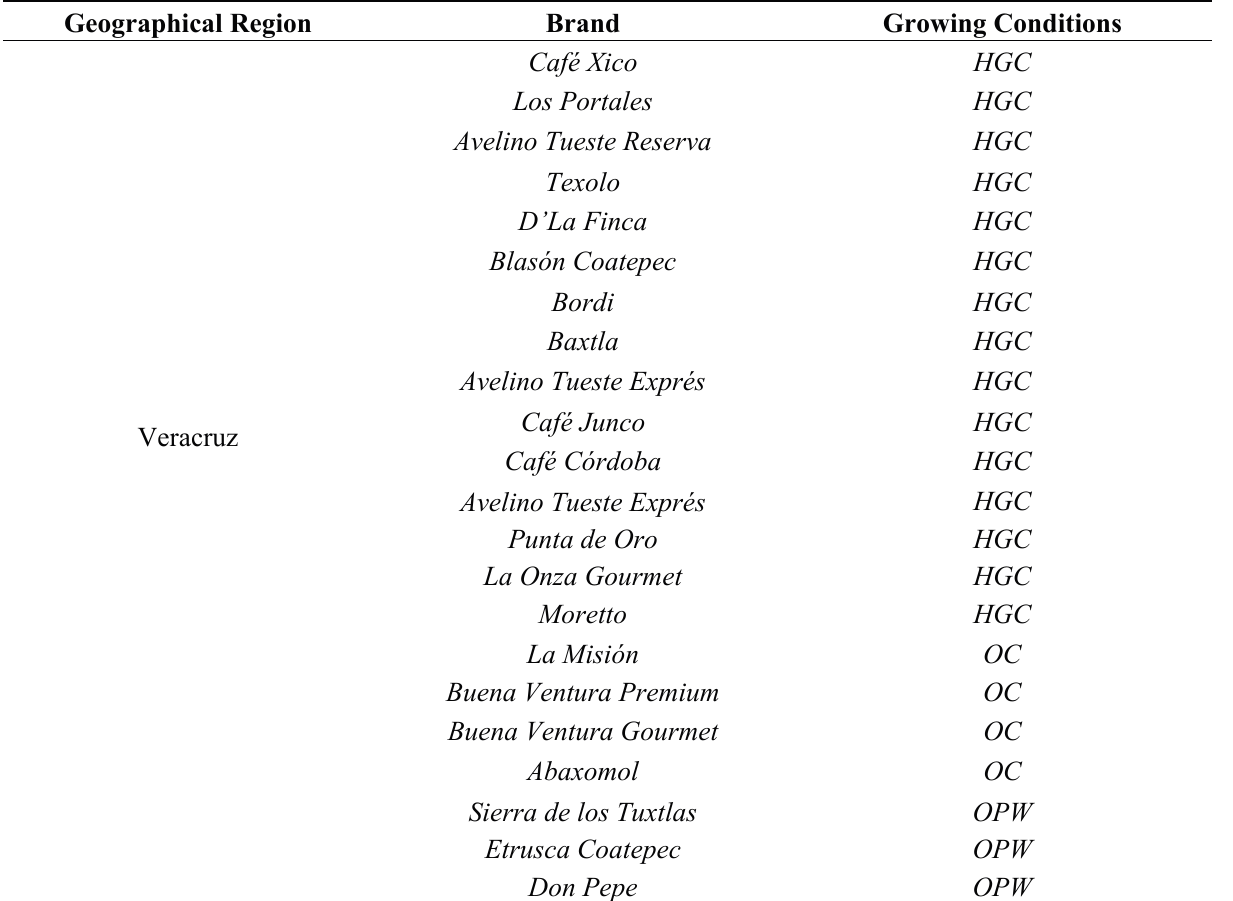
Table 1. Characteristics for the 42 coffee samples data